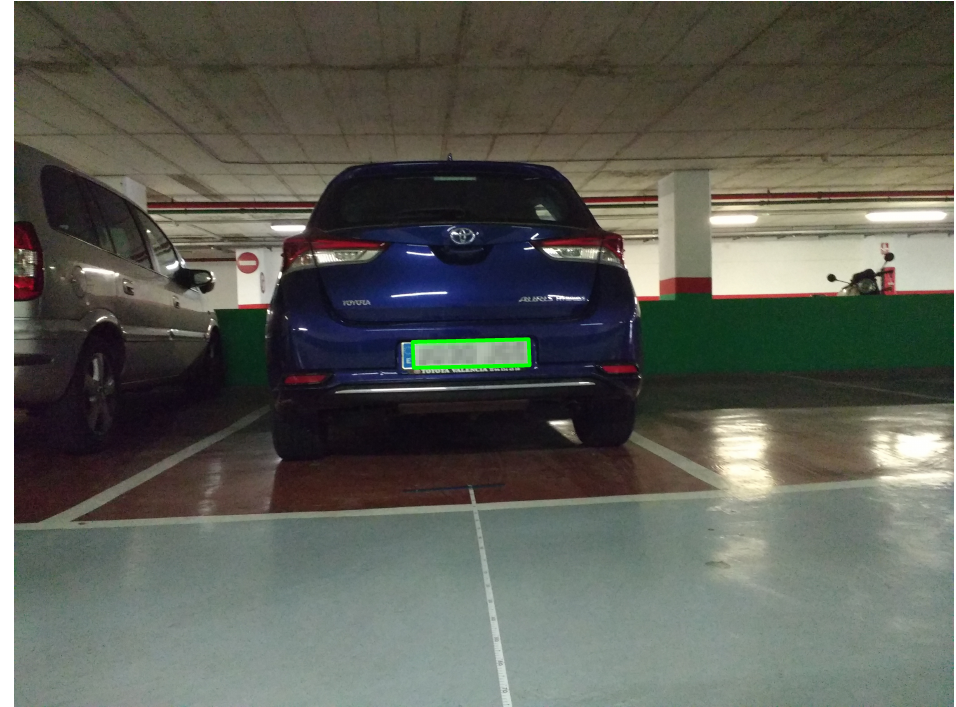
Figure 7. Inaccuracy in the identified plate area in one of erroneous cases.